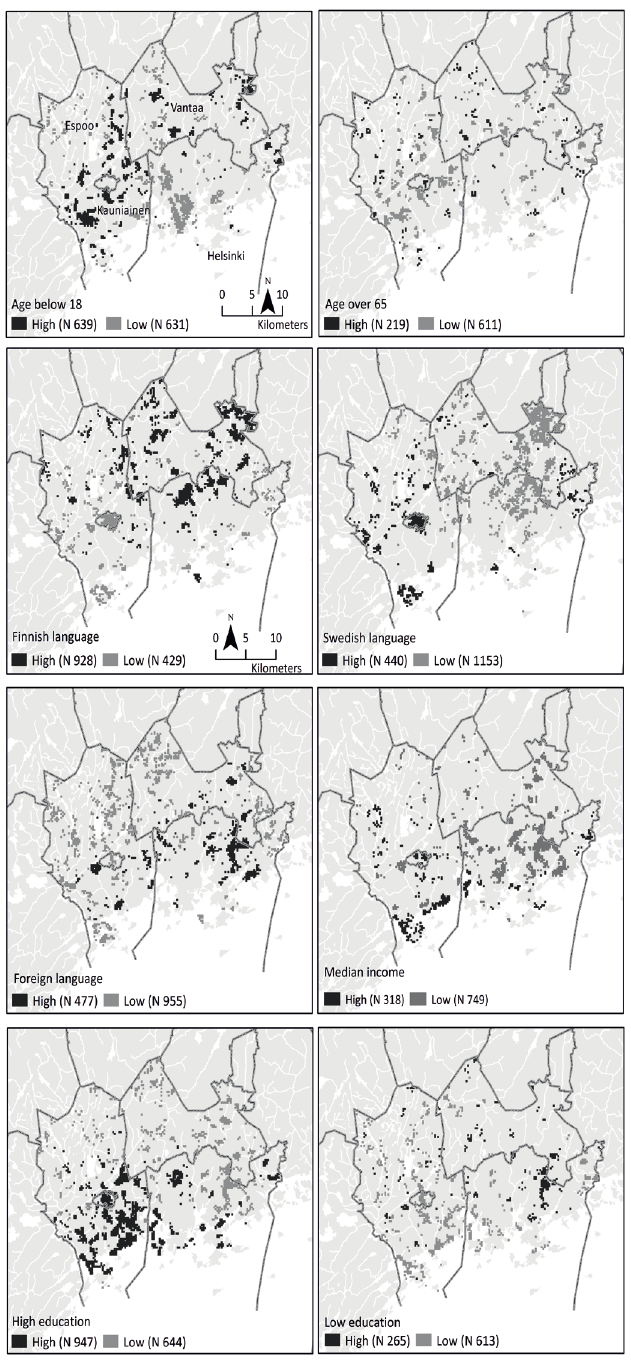
Fig. 2. Spatial distribution of statistically significant (p<0.05) high and low value residential clusters in the Helsinki Metropolitan Area